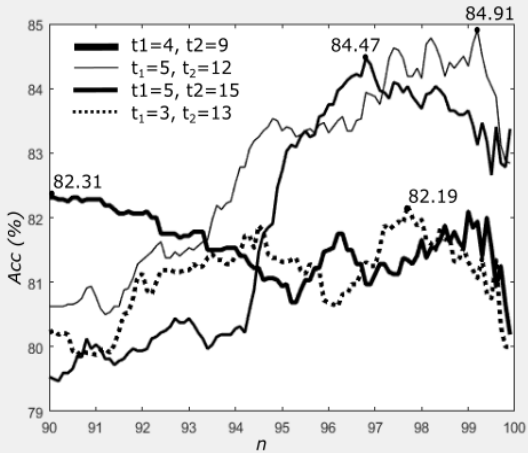
Figure 11. Quantitative results using different values of τ 1 and τ 2 on circle neighbourhood topology. Note that the x- axis and y- axis represent the accuracy (percentage of correctly classified cases) and the percentage of dominant patterns,